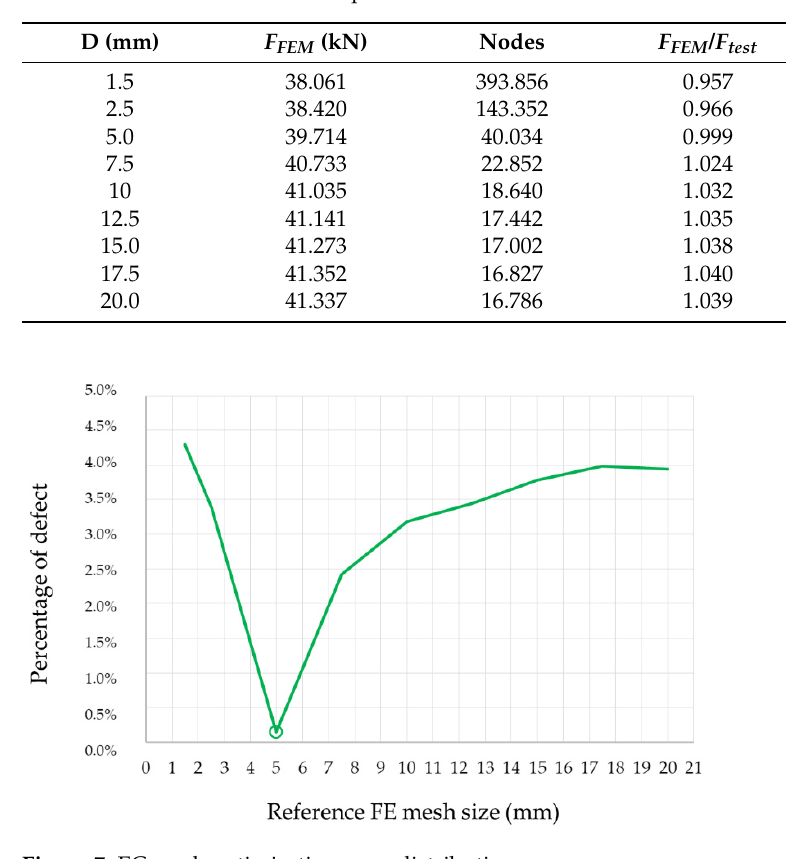
Figure 7. EC mesh optimisation error